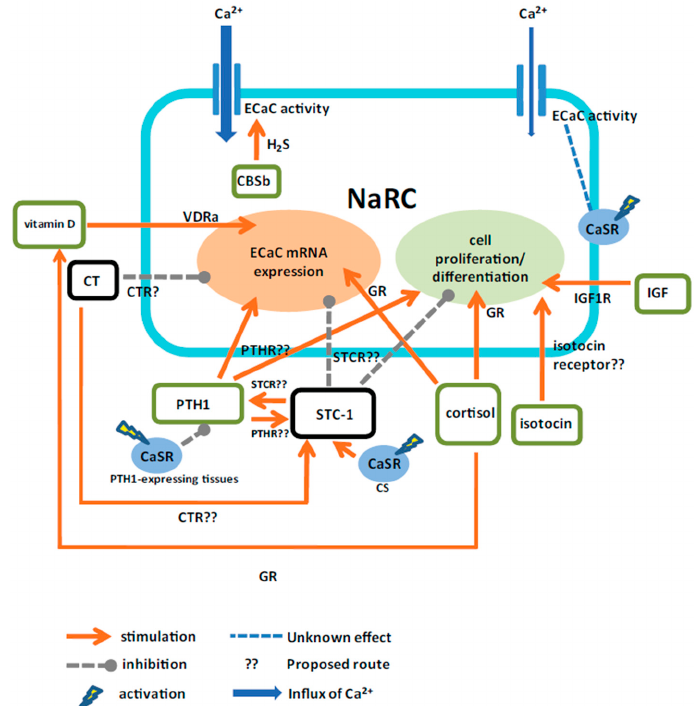
Figure 6. A proposed model for the actions of calcitropic hormones on zebrafish NaRCs.